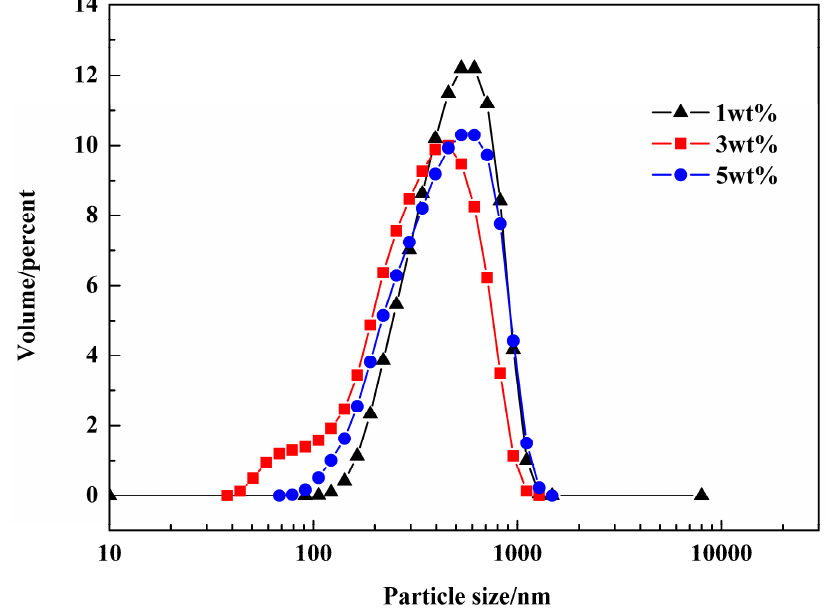
Figure 10. Size distributions of miniemulsions containing different dosages of emulsifier.